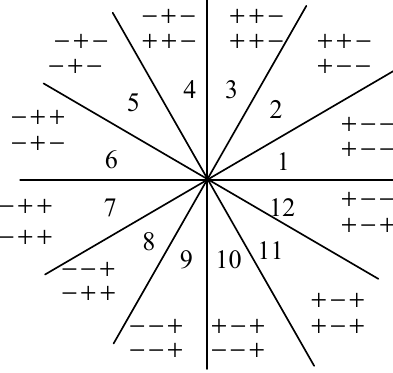
Figure 6. Relationship between the current vector angle and polarities of six-phase currents.